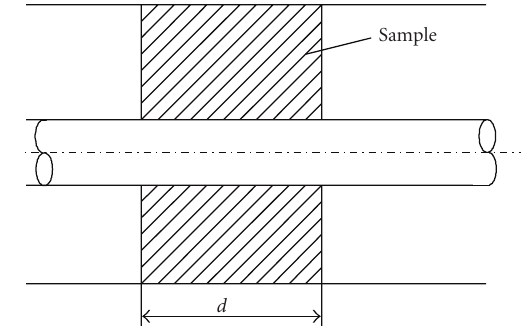
Figure 1: Coaxial line with annular disk of material.